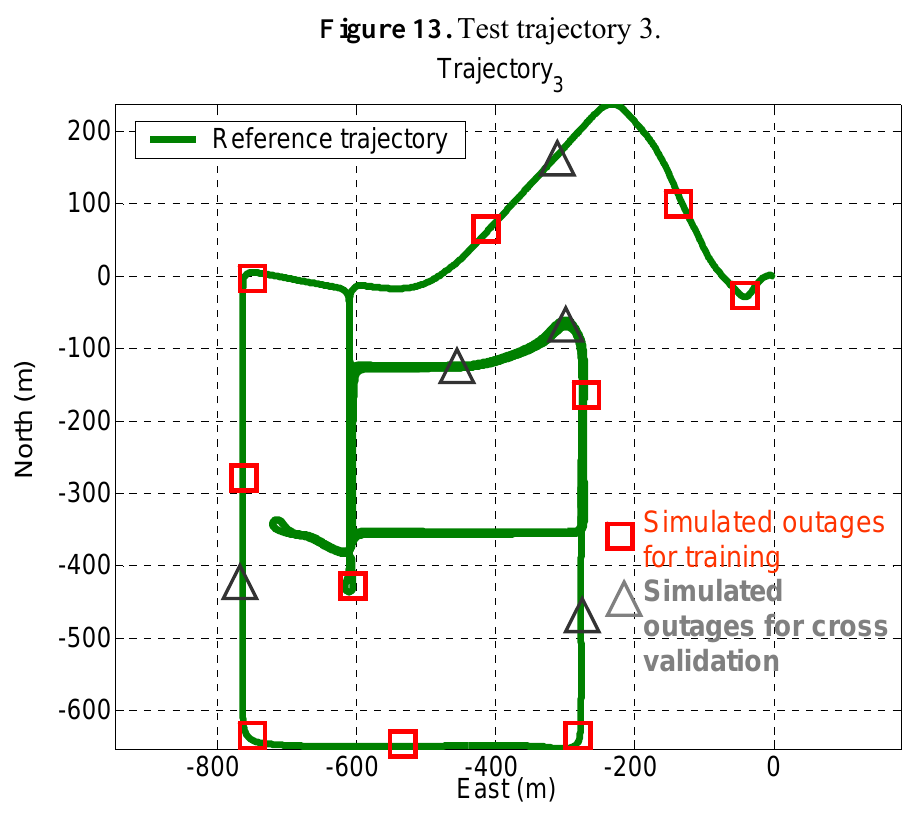
Figure 13. Test trajectory